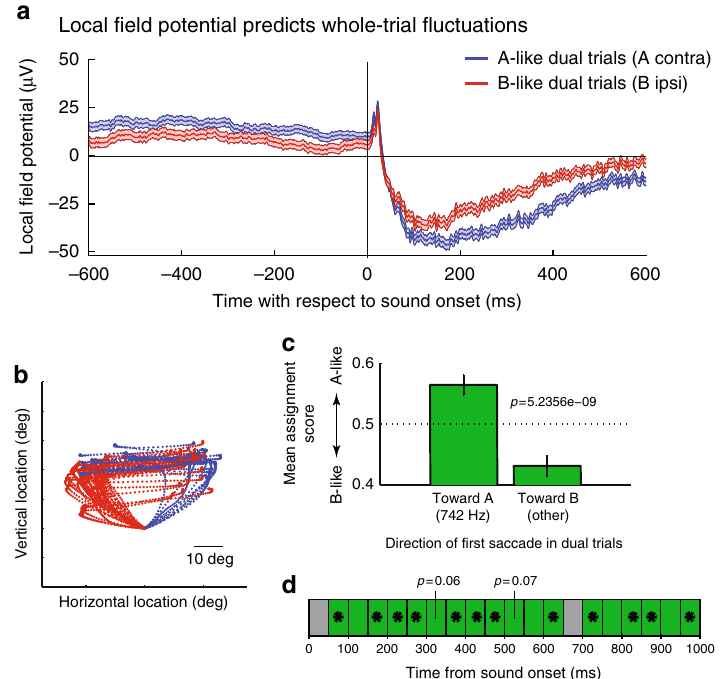
Fig. 5 Fluctuations can be predicted from pre-stimulus LFP and in turn predict behavior. a To assess the relation between the LFP prior to sound onset and the spiking response after sound onset, we assigned each dual-sound trial to one of two groups, A-like or B-like, based on whether the spike count matched the response to single-sound A or B (see Methods). We then compared the average LFP voltage (without fi ltering for any particular frequency band) of the two groups. The average LFP (mean ± SE) is shown in blue for 1917 trials classi fi ed as A-like (A = contralateral sound) and in red for 1565 trials classi fi ed as B-like. The traces are signi fi cantly different in the 600ms before sound onset and in the 600 ms after sound onset (two-tailed t -test, p < 0.01). b – d The target of the fi rst saccade on dual-sound trials can be predicted by the spike count during sound presentation. b Eye trajectories during dual-sound trials to the same pair of single-sounds (one triplet). The traces are color-coded based on which of the two sounds the monkey looked at fi rst in the response sequence. For clarity, all traces are aligned on a common starting position despite some variation in fi xation accuracy. c The average assignment score of trials in which the monkey looked at sound A fi rst is more A-like than that of trials in which the monkey looked at sound B fi rst. Bars indicate SEM; p value is for a two-tailed t -test involving a total of n = 1171 trials. d The relationship between assignment score and fi rst saccade target was also evident at the scale of 50 ms bins (green = positive correlation; * p < 0.05 for t -test of assignment score on A- fi rst vs. B- fi rst